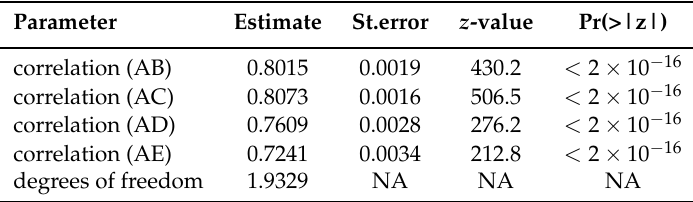
Table 7. Parametric estimates for t -copula, 5